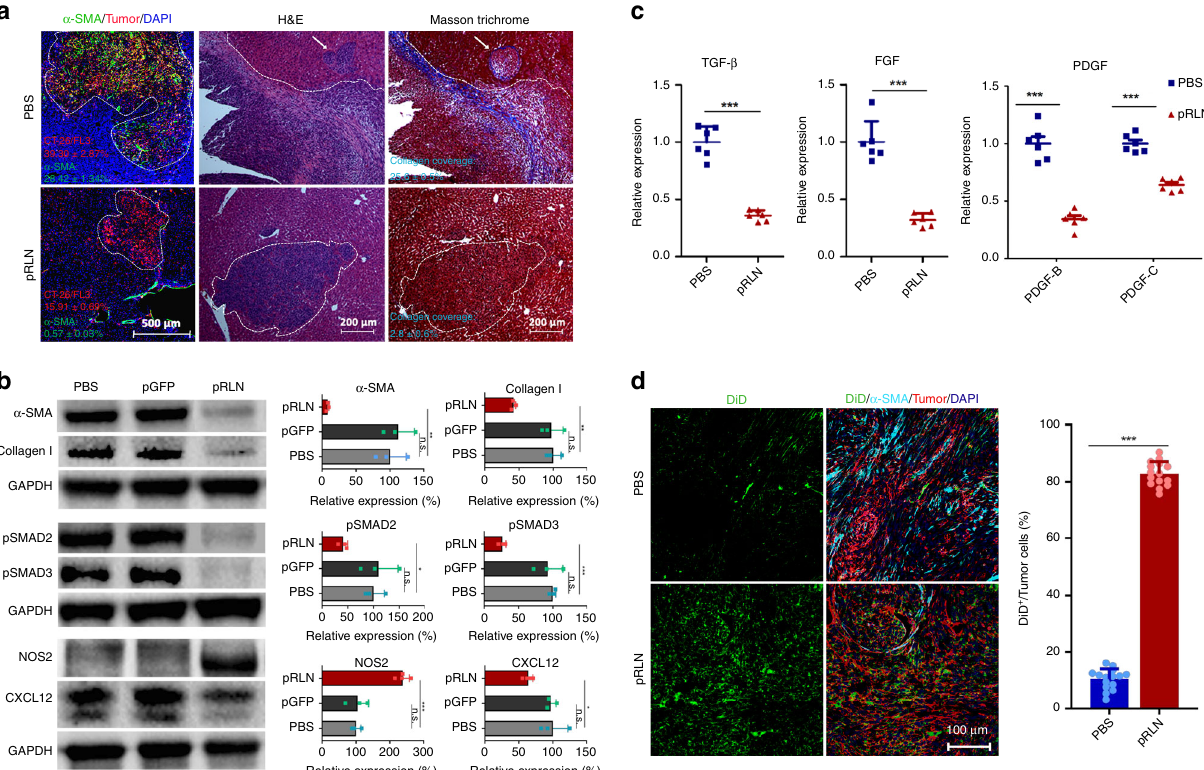
Fig. 3 RLN gene therapy remodels stromal environment in the metastatic lesion. a α -SMA and collagen downregulation and shrunk metastatic foci 4 days after three pRLN LCP (30 μ g pDNA every 2 days) i.v. injections in male mice bearing CT26-FL3 liver metastasis. Immuno fl uorescence staining of CT26-FL3 metastatic liver from PBS and pRLN treatment groups using anti- α -SMA (green) antibody and DAPI (blue). CT26-FL3 cells were colored red. Numbers in corresponding colors indicate the average % of tumor cells and α -SMA-positive cells quanti fi ed in fi ve randomly selected fi elds per mouse ( n = 3). H&E and Masson ’ s trichrome staining were performed in adjacent sections. White dotted line and arrow indicate the metastatic foci. Bars in the left two, right four panels represent 500, 200 μ m, respectively. The average % collagen (blue staining) coverage was calculated in fi ve randomly selected fi elds per mouse ( n = 3). b Western blot analysis of aHSC markers ( α -SMA and Collagen I, CXCL12), TGF- β downstream proteins (pSMAD2 and pSMAD3), and NO pathway indispensable protein (NOS2) in CT26-FL3 metastatic livers after RLN gene therapy ( n = 3). c Relative mRNA expression of pro fi brogenic factors (TGF- β , FGF, and PDGF) in CT26-FL3 metastatic livers after RLN gene therapy ( n = 6). d Distribution of second-wave nanoparticles (DiD/LCP) in the metastatic liver of mice receiving PBS or RLN gene therapy. Immuno fl uorescence staining of CT26-FL3 metastatic liver using anti- α -SMA (cyan) and DAPI (blue). DiD/LCP and tumor cells were colored green and red, respectively. % DiD positive signals are normalized by tumor cell occupation in fi ve randomly selected fi elds per mouse liver ( n = 3). Bar represents 100 μ m. Signi fi cant differences were assessed using t test. Results are presented as mean (SD). * p < 0.05, ** p < 0.01, *** p < 0.001, n.s., not signi fi